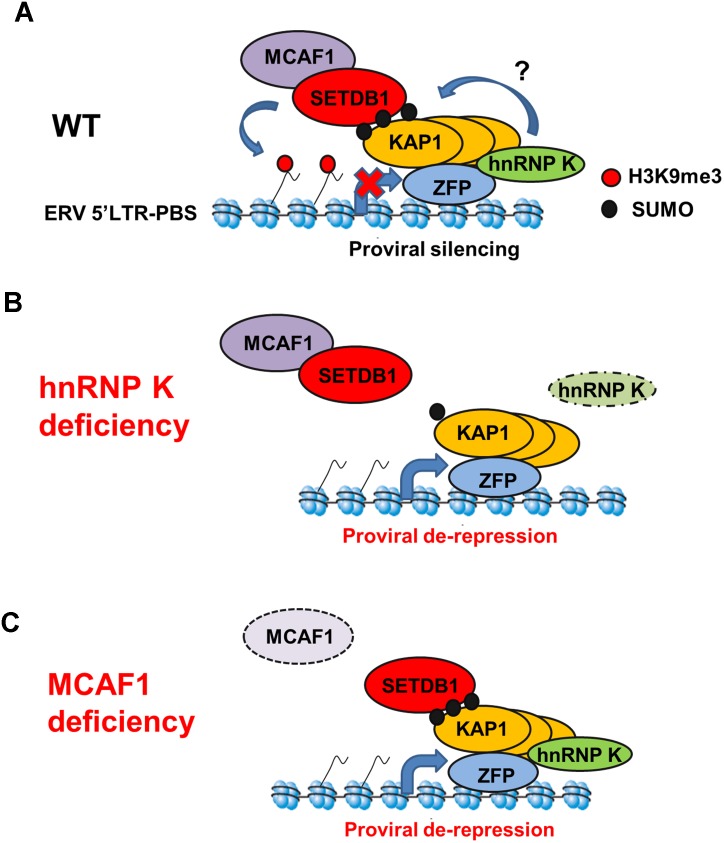
Model for SETDB1/KAP1-mediated proviral silencing pathway.(A) In wt mESCs, KRAB-ZFPs recruit KAP1 subunits and unmodified KAP1 recruits hnRNP K. SUMOylation of KAP1 and/or other proteins on chromatin is promoted by hnRNP K, resulting in recruitment of SETDB1/MCAF1 and deposition of H3K9me3. (B) In hnRNP K-deficient cells, the SUMOylation of KAP1 on chromatin is compromised, leading to loss of SETDB1 recruitment, loss of H3K9me3 and induction of proviral expression. (C) In MCAF1-deficient cells, SETDB1 recruitment is maintained but H3K9me3 is no longer deposited efficiently, leading to proviral de-repression.